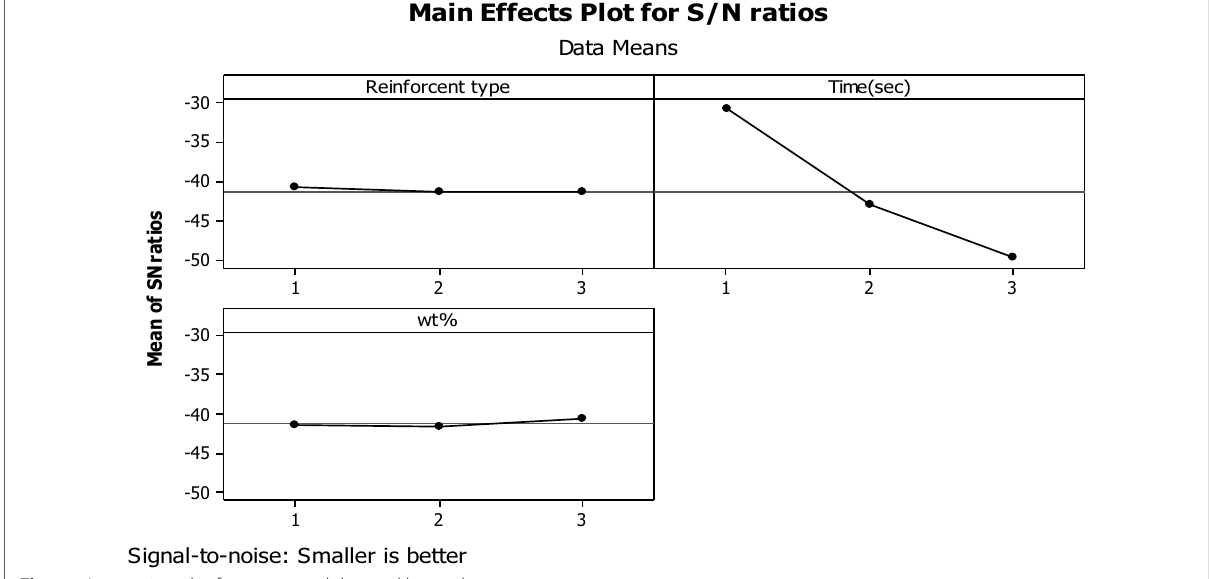
Fig. 11 Interaction plot for means and the total heat release rate